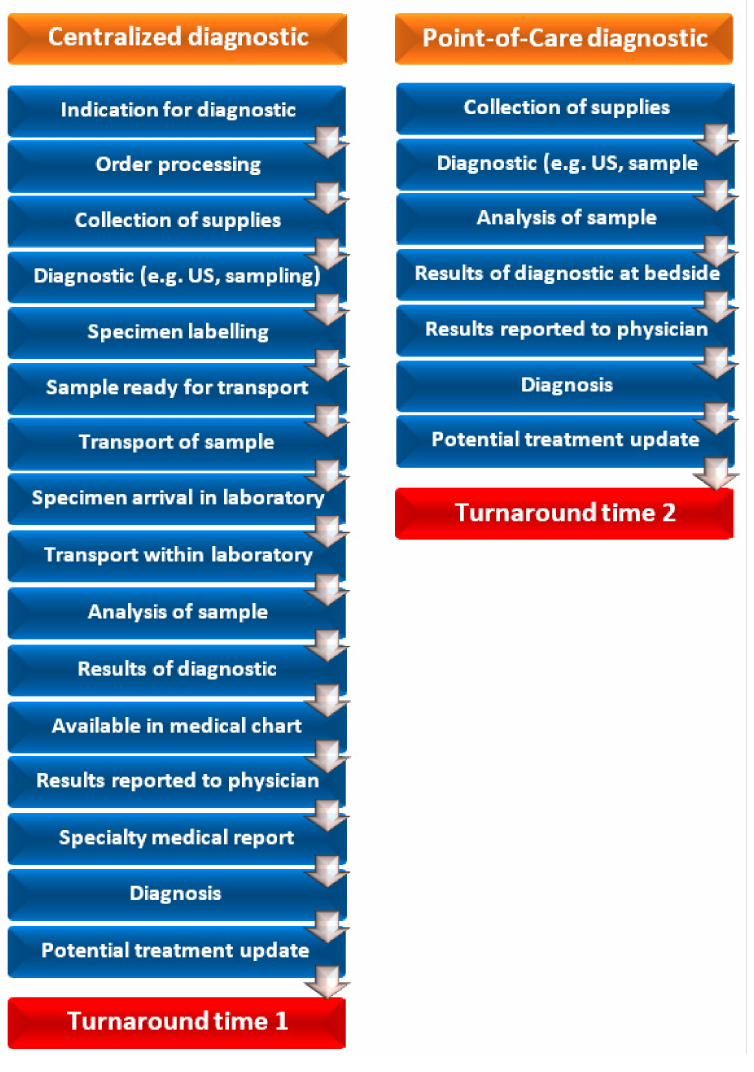
Figure 1. Model of activities comparison of point-of-care and central centralized diagnostics. US reflects